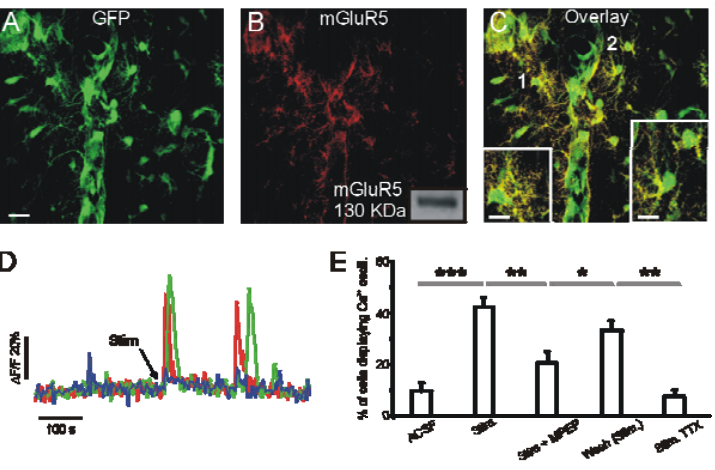
FIGURE 2 . mGluR5 receptors mediate astrocyte activation following stimulation of neuronal afferents. (A–C) mGluR5 receptors (B, red) are expressed in nucleus accumbens astrocytes, identified by the expression of GFP (A, green). (D,E) Stimulation of glutamatergic afferents to the nucleus accumbens with trains of stimuli results in mGluR5-dependent activation of Ca 2+ signaling into astrocytes. Ca 2+ signals consist of repetitive, brief Ca 2+ spikes. (Modified from D'Ascenzo et al.[53], copyright Proc. Natl. Acad. Sci. U. S. A